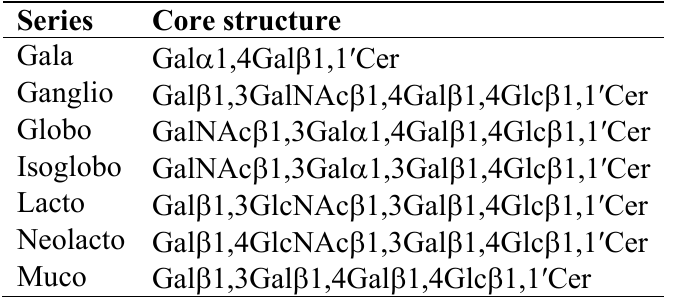
Table 1. Glycosphingolipid (GSL) series of higher eukaryotes [1].